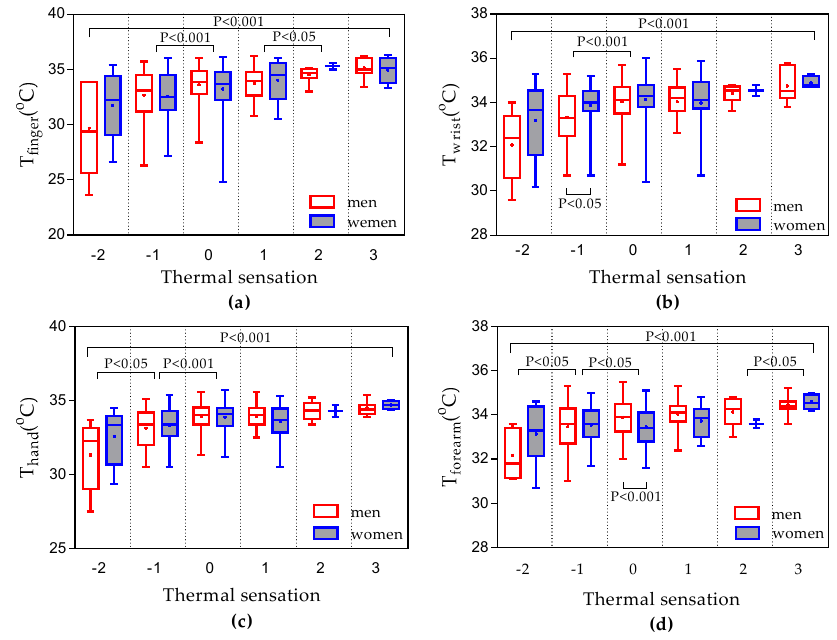
Figure 11. Upper extremity skin temperatures results: ( a ) sex difference in T finger ( b ) sex difference in T wrist ( c ) sex difference in T hand ( d ) sex difference in T forearm . Table 5. Mean upper extremity skin temperatures of investigated